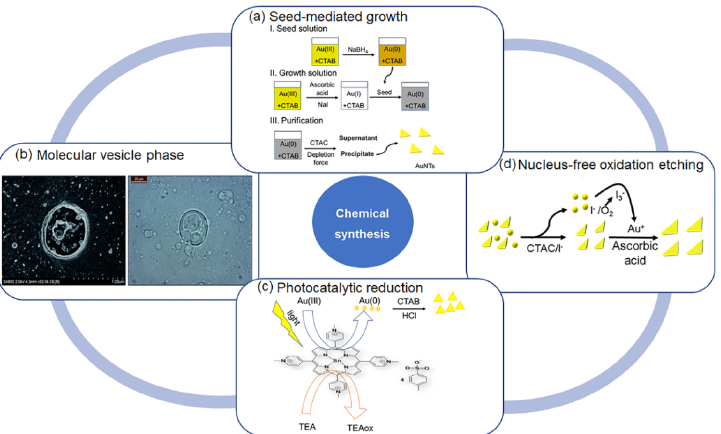
Figure 2. Chemical synthesis of AuNTs based on ( a ) seed ‐ mediated growth; ( b ) molecular vesicle phase. Reprinted with permission from Ref. [61]. Copyright © 2022 The Royal Society of Chemistry; ( c ) photocatalytic reduction; and ( d ) nucleus ‐ free oxidative etching.